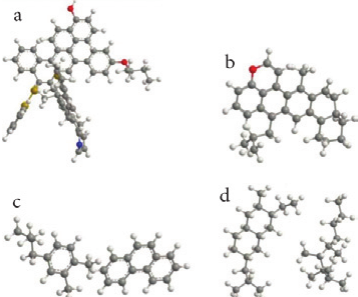
fig. 1. Fractional composition of bitumen expressed by molecular